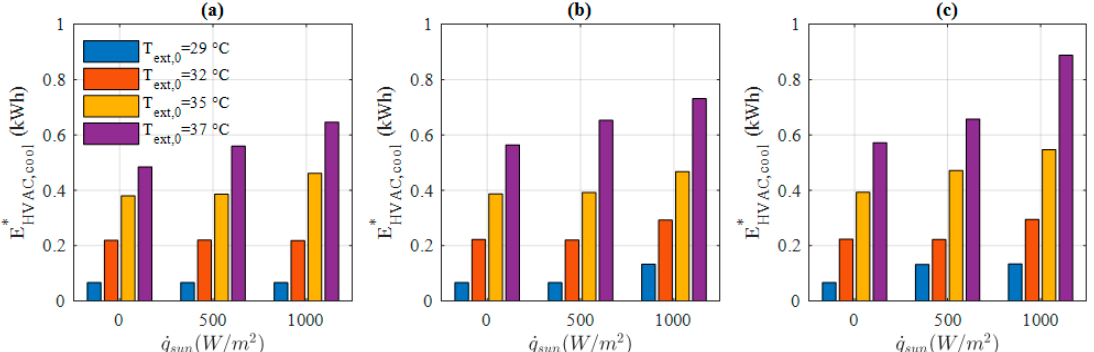
Figure 11. Cooling consumption E ∗ for four T ext ( t ) and three RH ext ( t ) characterized by: ( a ) HVAC , cool = 35% , ( b ) (cid:1844)(cid:1834) = 55% , and ( c ) (cid:1844)(cid:1834) = 75% . (cid:1844)(cid:1834) (cid:3032)(cid:3051)(cid:3047),(cid:2868) (cid:3032)(cid:3051)(cid:3047),(cid:2868) (cid:3032)(cid:3051)(cid:3047),(cid:2868)